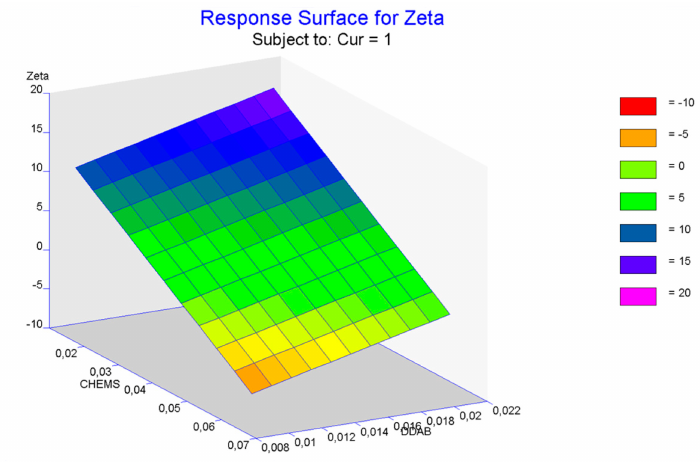
Figure 8. Surface plots for zeta potential